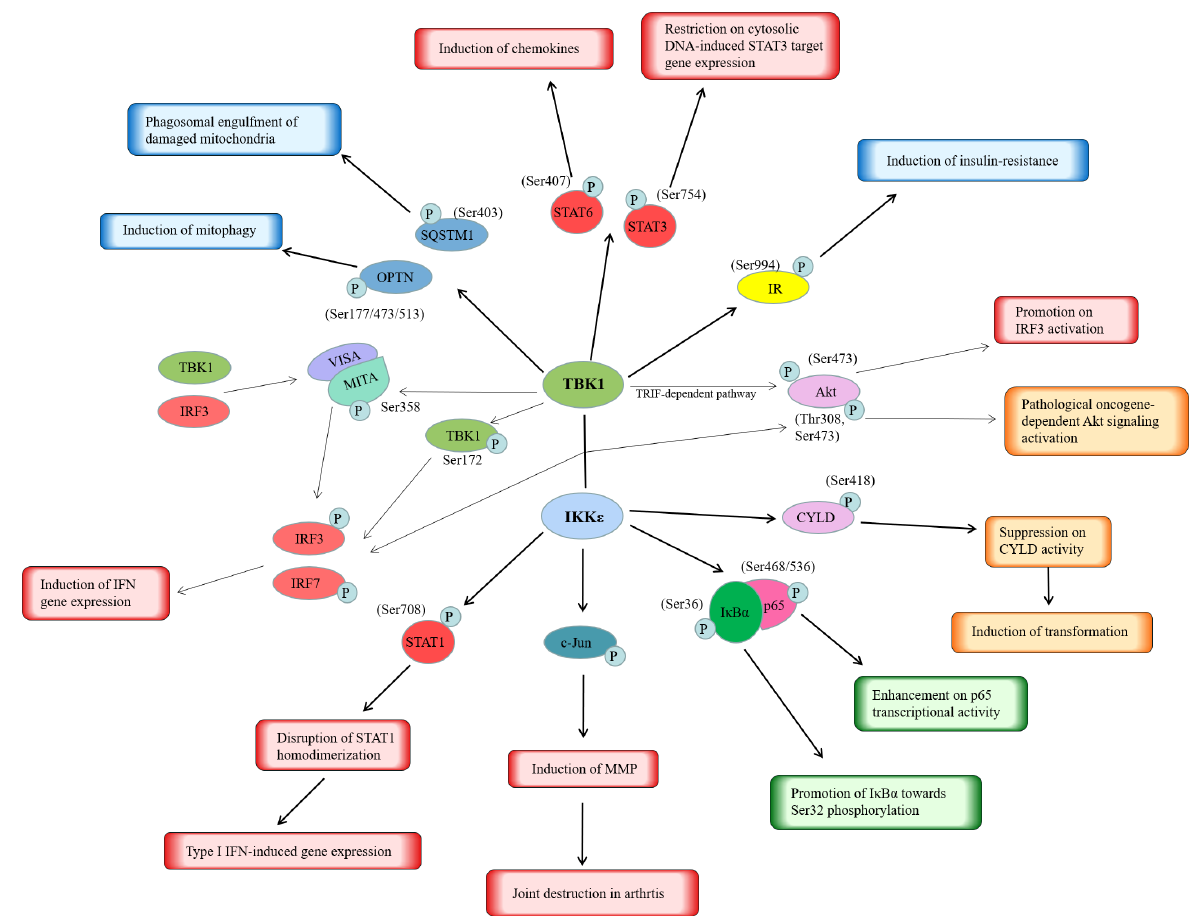
Figure 3. The substrates of TBK1 and IKKε and the related functions. Activated IKKε and TANK-binding kinase 1 (TBK1) modify numerous substrates and function in many biological processes, such as immune response, cell proliferation and survival, insulin signaling, and autophagy, some of which result in immune disorders and